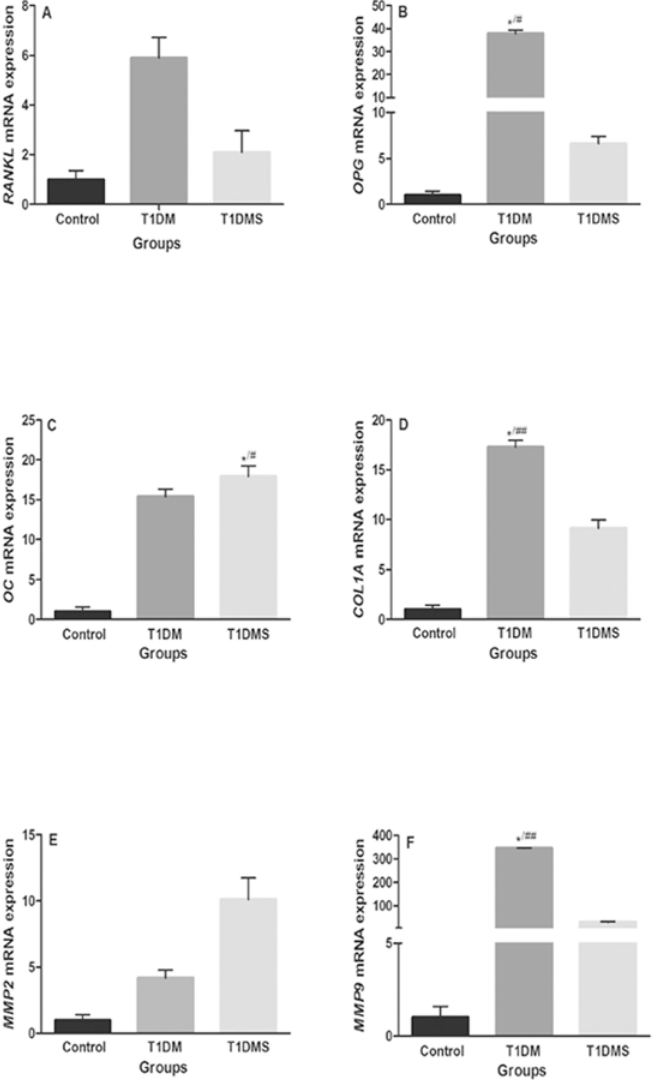
Fig 4. Relative mRNA expression quantification. RANKL (A), OPG (B), OC (C), COL1A (D), MMP-2 (E), and MMP-9 (F) mRNA expression in bone tissue of control, type 1 diabetes mellitus (T1DM), and T1DM plus zinc supplementation (T1DMS) rats. All data are expressed as fold-change vs. control group values, normalized to GAPDH . Comparisons between groups were analyzed with Kruskal-Wallis ANOVA on Ranks and Dunn ’ s post-hoc. p < 0.05 * /# vs. control group; p < 0.01 * /## vs. control group.